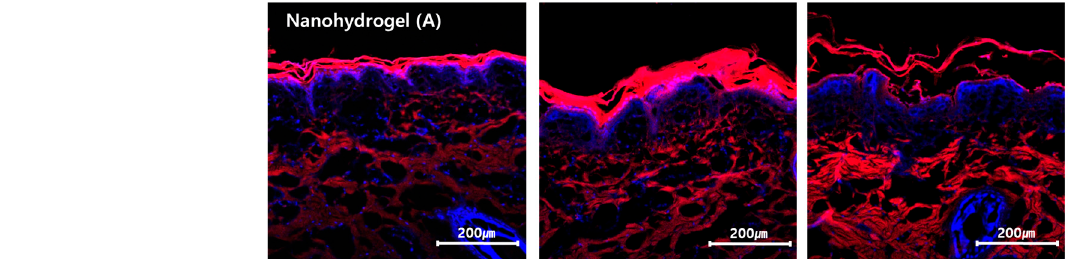
Figure 6. Merged CLSM images of a cross section of the minipig skin incubated with nanohydrogel (A) and ICG as a control at various permeation times (24, 48, and 72 h) (Red: ICG, Blue: cell nuclei of the skin) (Scale bar: 200 μ m).